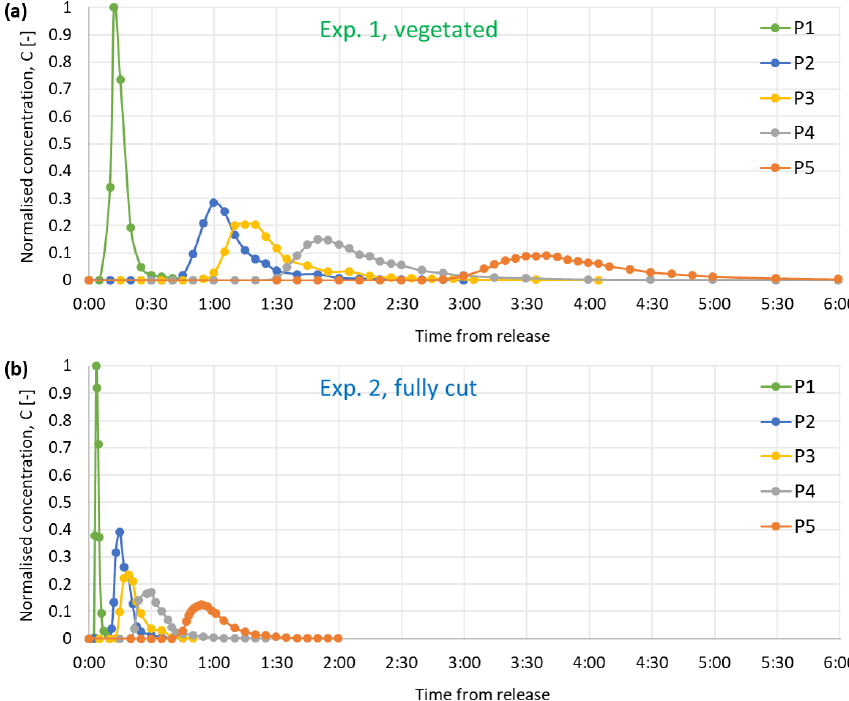
Figure 7. Tracer concentrations in the five cross-sections (P1–P5) normalised with the maximum concentration in the first cross-section P1: (a) vegetated conditions (Exp. 1) and (b) fully cut conditions (Exp. 2).